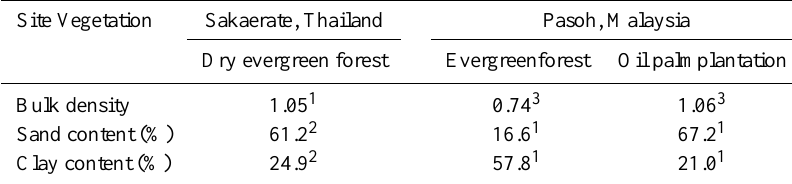
Table 2. Soil parameters measured at the dry evergreen forest (DEF) in Thailand and the rainforest (RF) and oil palm plantation (OPP) in Malaysia.